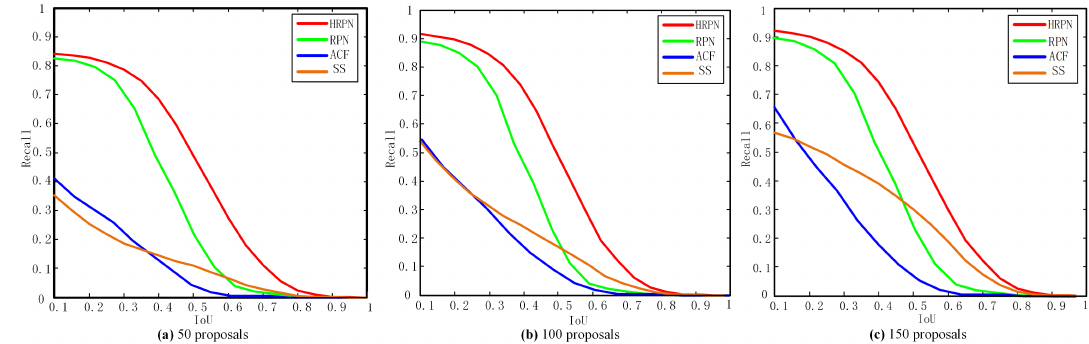
Figure 6. Recall versus Intersection-over-Union (IoU) threshold on the Munich Vehicle test set. ( a 50 region proposals; ( b ) 100 region proposals; ( c ) 150 region